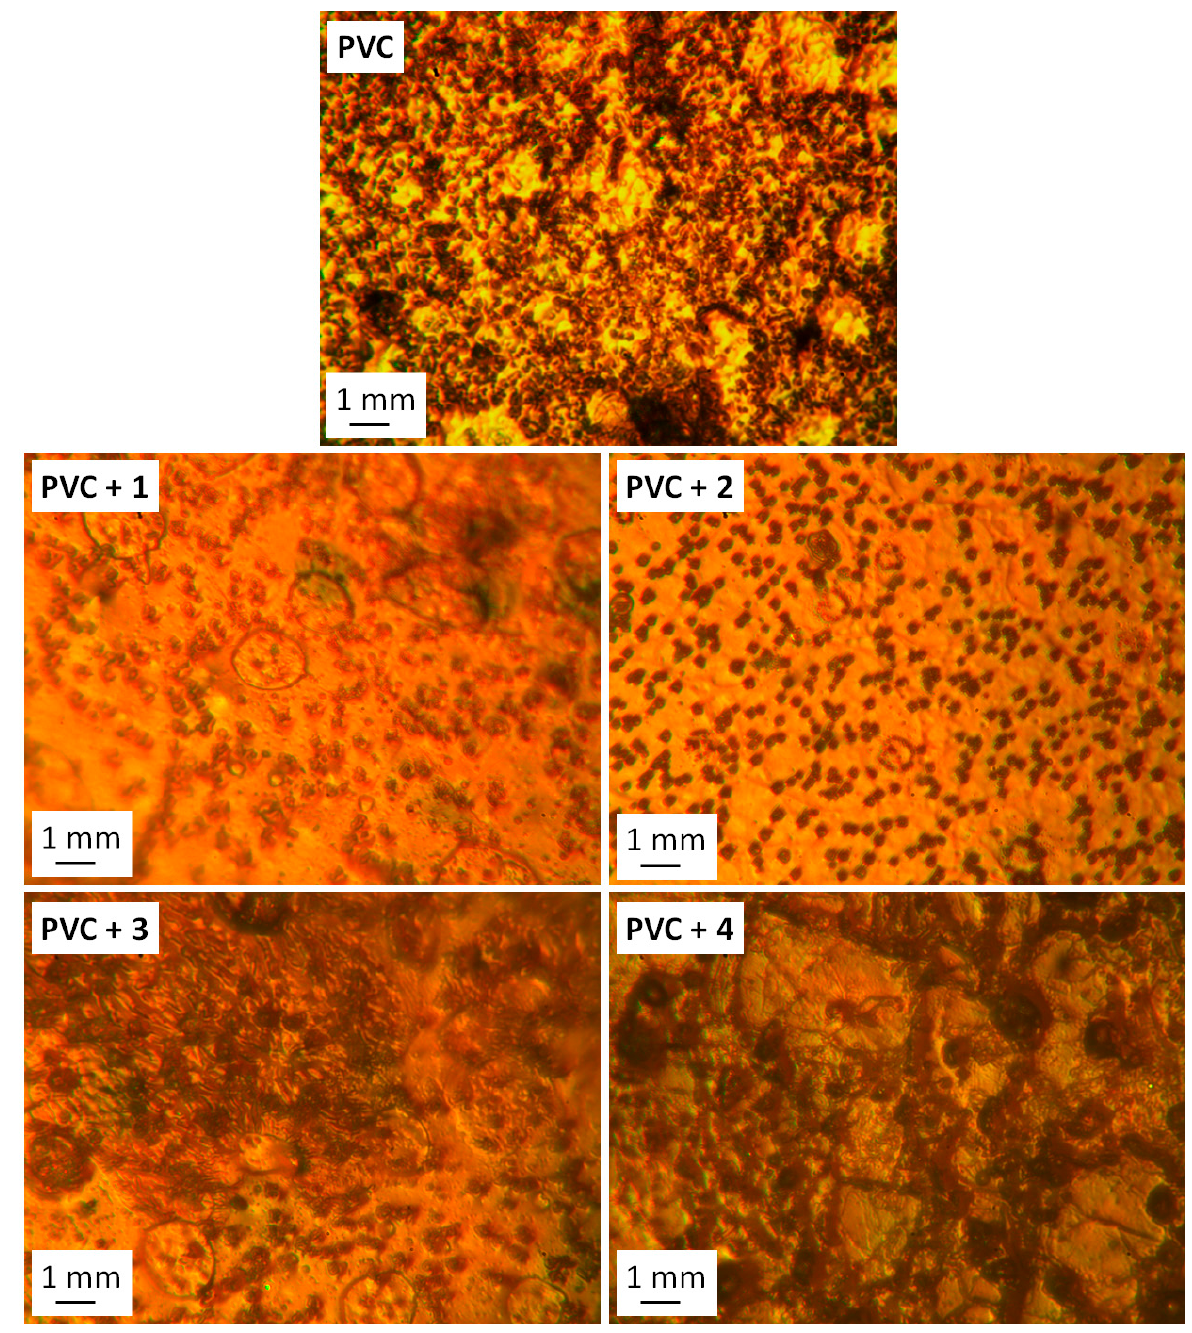
Figure 6. Microscope images of PVC films.